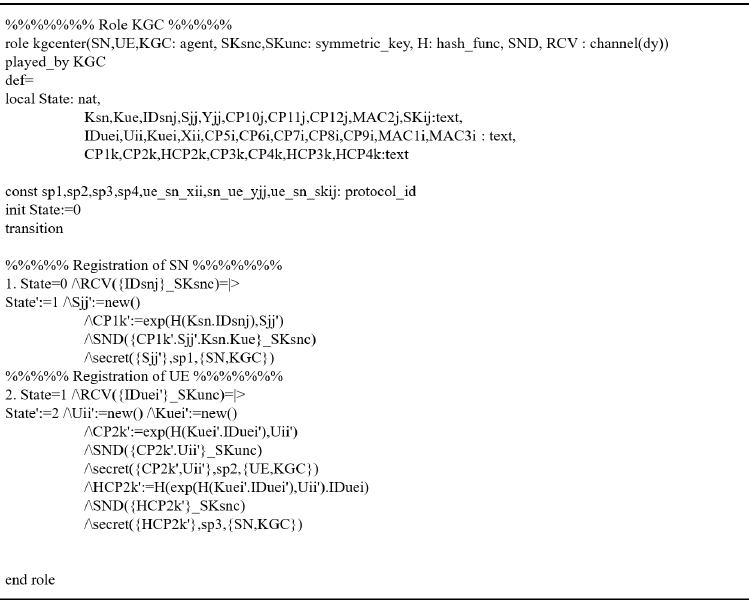
Figure 5. Scenario 1: HLPSL description of KGC